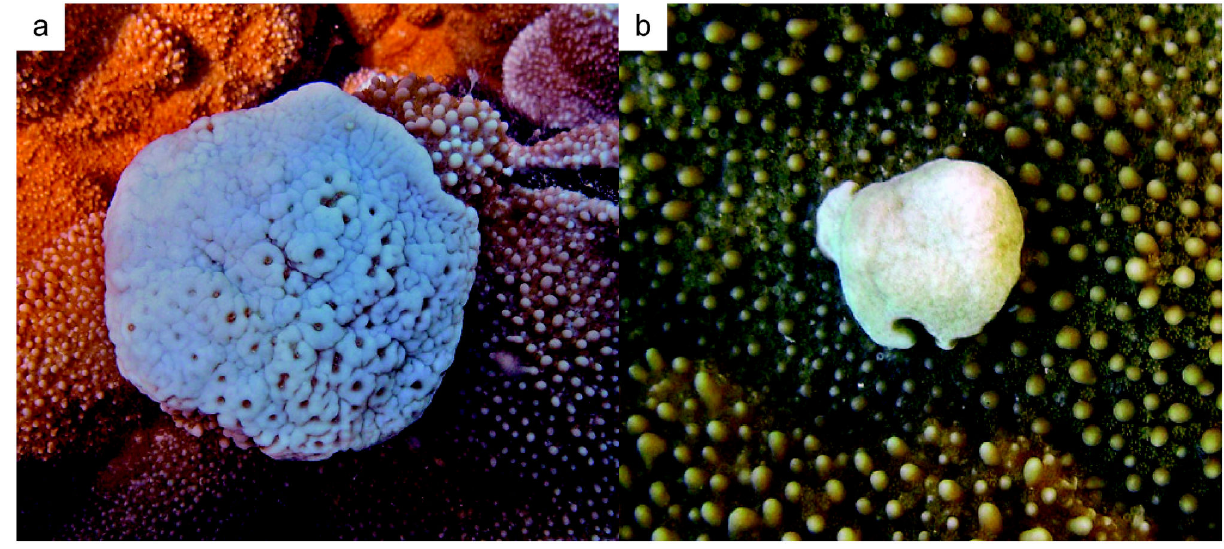
Figure 1. Type A and Type B GA morphology. Photographs of Type A and Type B GA tissue. a Type A GA, note reduction in polyps, fused tuberculae, and pale appearance b Type B GA, note complete lack of polyps, fused protuberant coenosteum, and pale